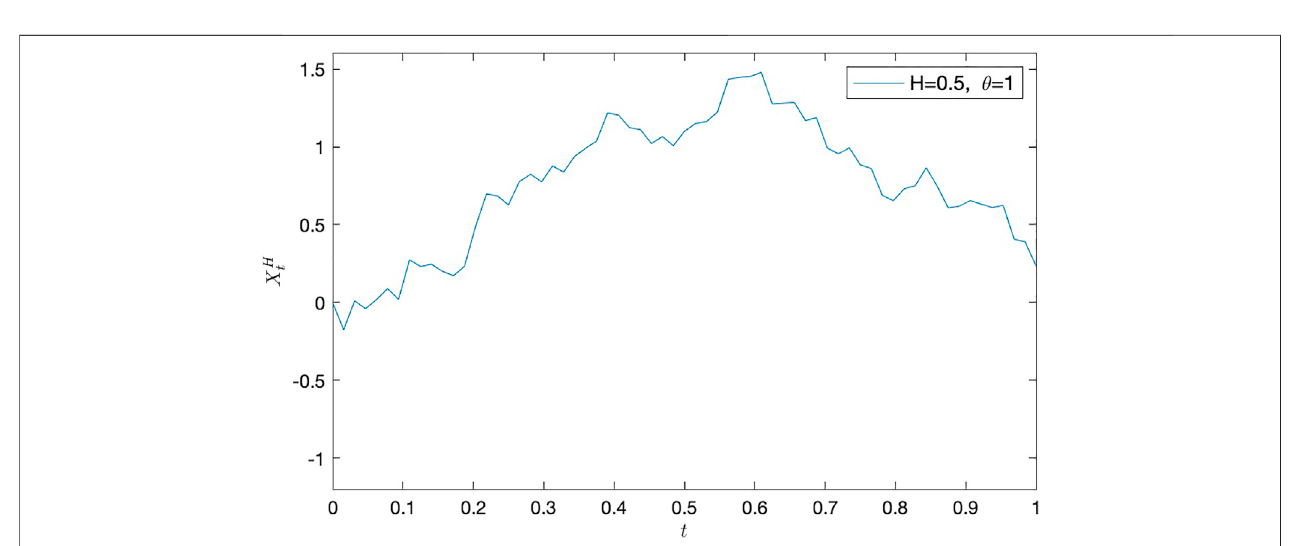
FIGURE 4 | Path of X H with θ (cid:1) 1 and H (cid:1) 0.5.